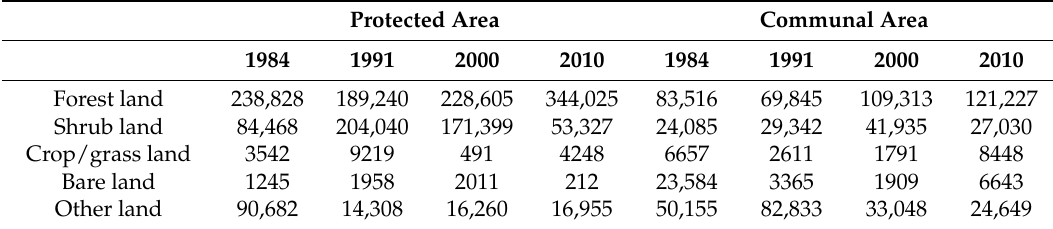
Table 4. Area statistics (ha) of the LULC classes (Source: Ref. [18]).